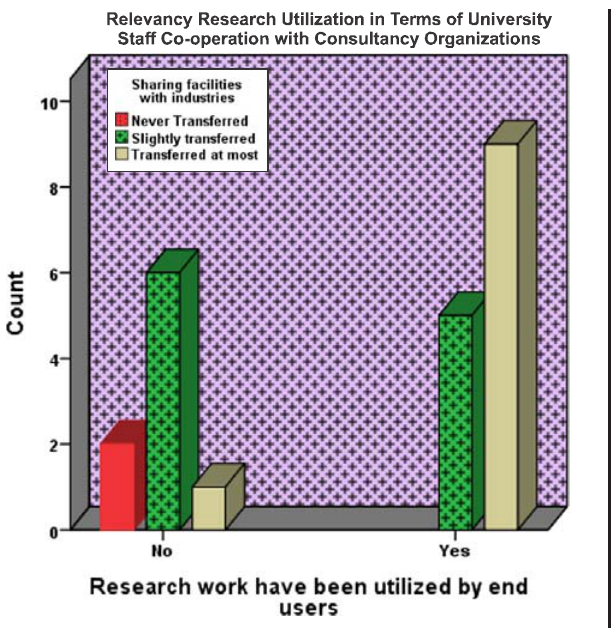
FIG. 9. ROLE OF SHARING OF INSTITUTIONAL FACILITIES WITH INDUSTRY AND OTHER END USERS TOWARDS UTILIZATION OF KNOWLEDGE